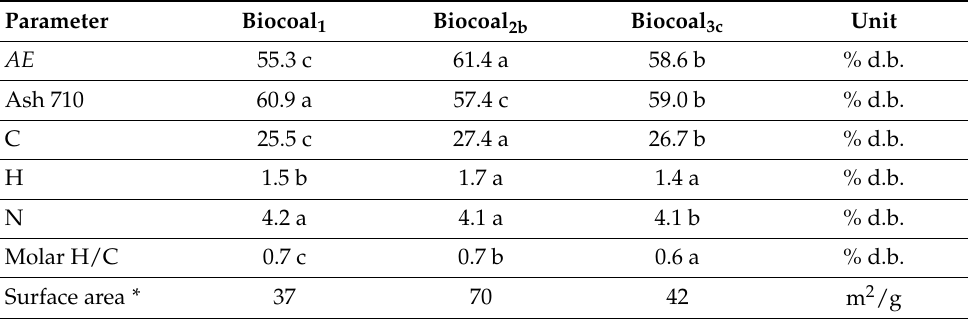
Table 15. Ash extraction efficiency ( AE ) and characterization of the extracted biocoals case 1 (biocoal 1 ), case 2 (biocoal 2b ), and case 3 (biocoal 3c ). Different letters in the same row indicate significant differences between means for p < 0.05 ( n = 3).